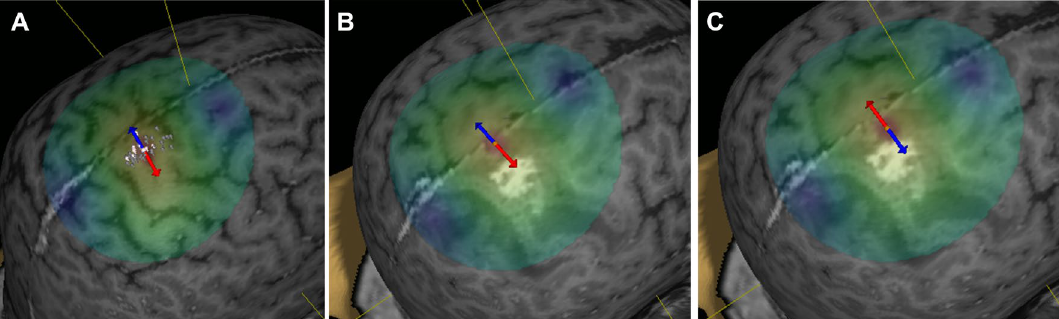
Figure 1. ( A ) Positive and negative stimulations within the leg area in a patient with Glioblastoma. Positive responses are indicated in white and negative stimulations are marked in grey. The electric field orientation is shown as the red and blue arrow. ( B , C ) Orientation of the stimulation coil during mapping of the leg motor area of a different patient. Electric field orientation with the main orientation towards the interhemispheric fissure (blue arrow lateral) and towards the hemisphere of interest (red arrow